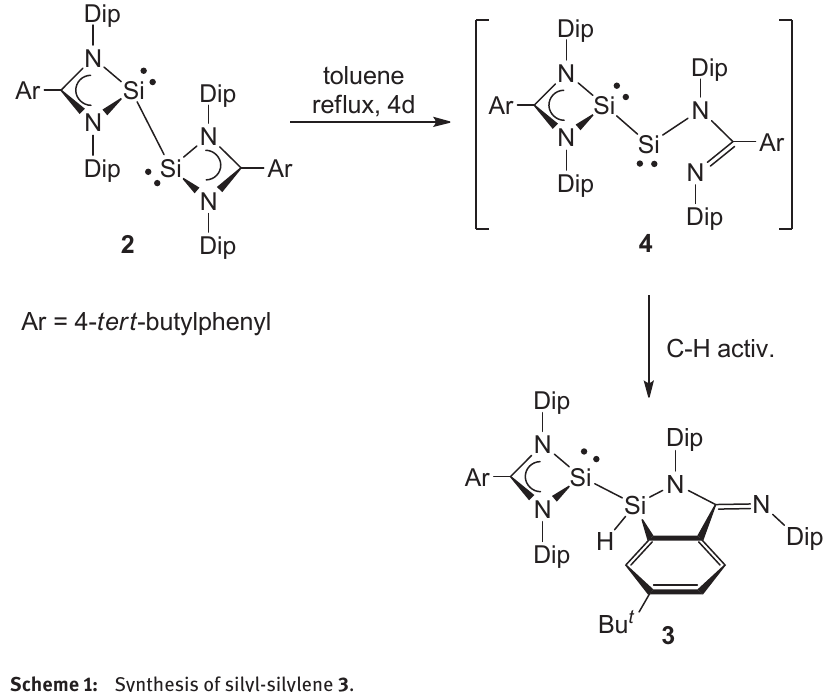
Scheme 1: Synthesis of silyl-silylene 3